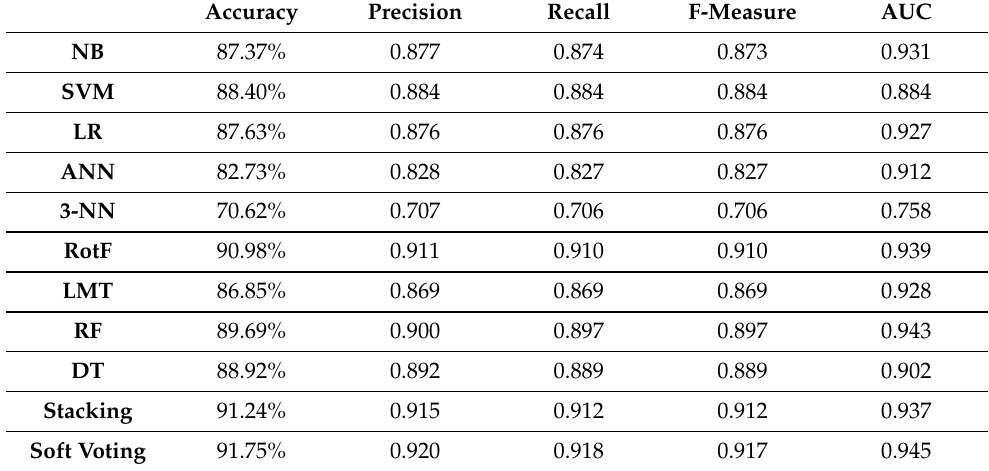
Table 4. Performance Evaluation of ML